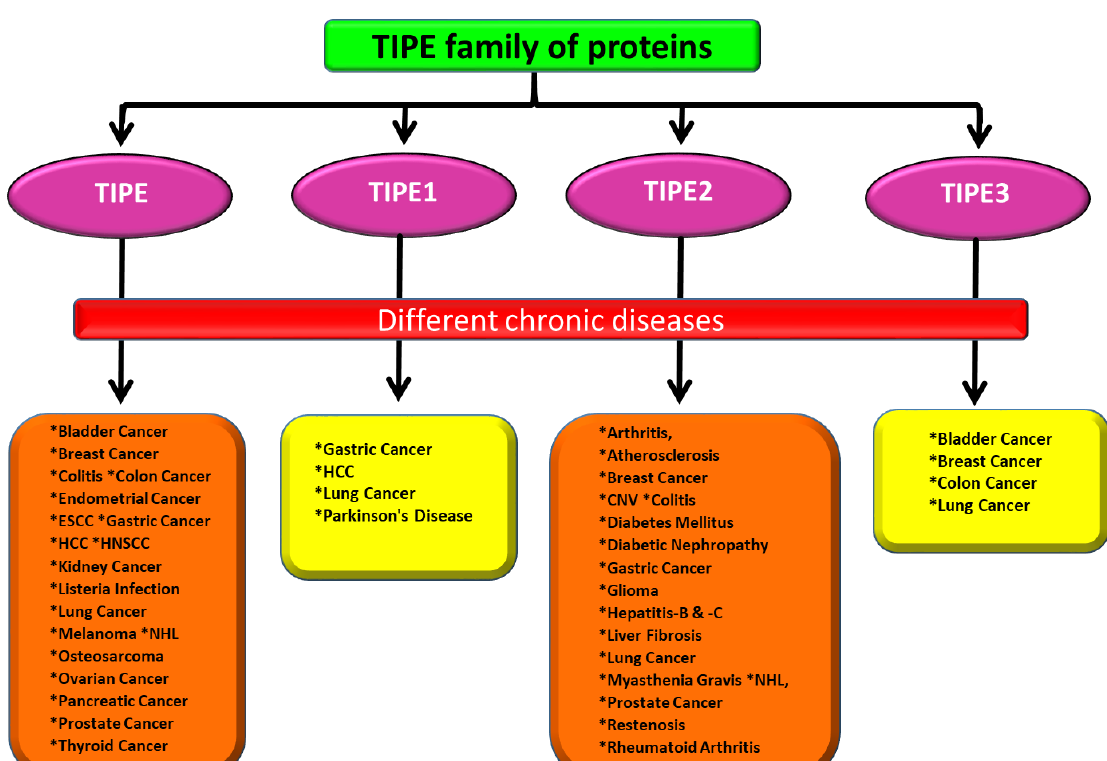
Figure 1. Various chronic diseases associated with TIPE family of proteins.